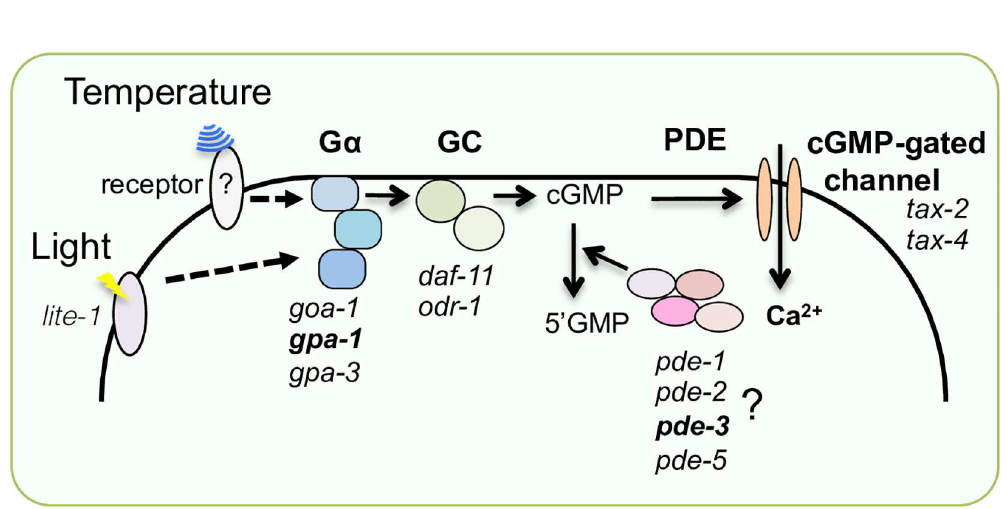
Fig 8. A molecular model for light and temperature signaling in ASJ sensory neuron, which controls cold tolerance. Some moleculesare thought to be common, and some specific, to the temperature- and light-signaling pathways of ASJ. Gene name shown in bold indicate molecules specific to temperature signaling.Because the temperature response was not completely extinguished in the mutants in this study, unidentifiedsignaling moleculessuch as G α , GC and PDE may also be requiredfor temperaturesignaling.The temperature receptor has not been